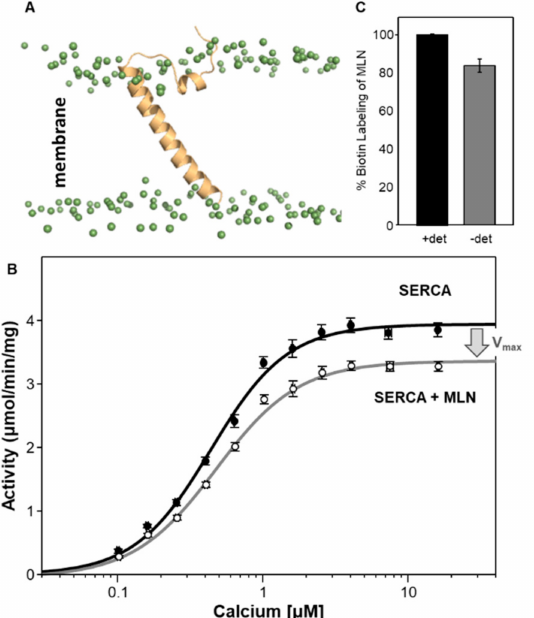
Figure 5. SERCA and myoregulin (MLN). ( A ) Molecular model of MLN in a lipid bilayer. The phospholipid headgroups of the lipids are indicated as green spheres. The N-terminal cytoplasmic domain of MLN (residues 1–16) is largely unstructured and lies along the membrane surface and the transmembrane domain (residues 17–46) is inclined approximately 60 ◦ relative to the bilayer surface (~30 ◦ relative to the bilayer normal). ( B ) Calcium-dependent ATPase activity of SERCA reconstituted into membrane vesicles in the absence (black) and presence of MLN (gray). The change in the maximal activity (V max ) of SERCA is indicated by an arrow. Each data point is the mean ± standard error ( n ≥ 3). ( C ) Biotin labeling and sidedness of MLN in the co-reconstituted proteoliposomes in the absence and presence of detergent. On average, 84 ± 1% of the MLN peptides are correctly oriented with their cytoplasmic domains on the exterior surface of the co-reconstituted